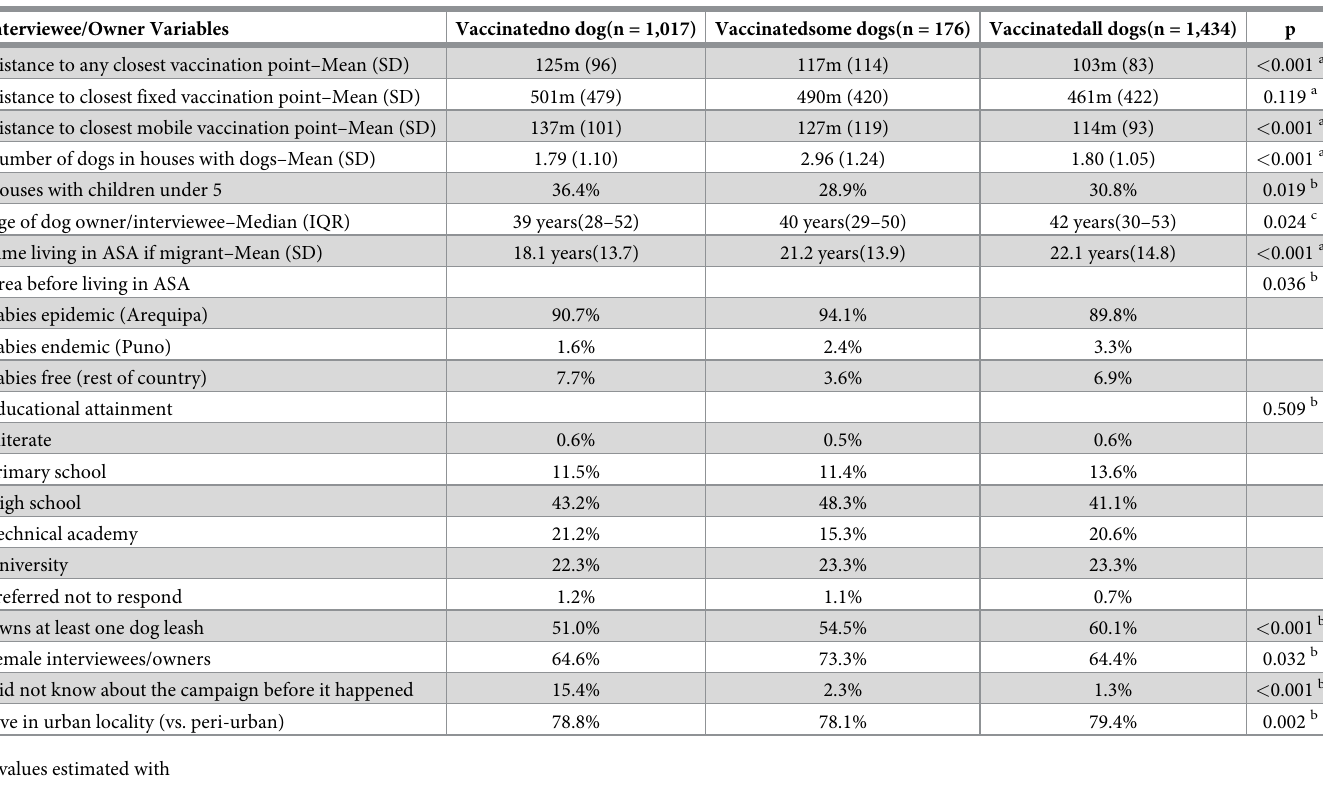
Table 1. Characteristics of the dog owner population in the study area by participation in the MDVC, Arequipa City, Peru, 2016. Interviewee/Owner